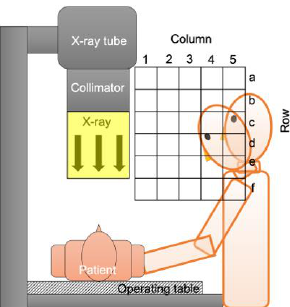
Figure 4. Analysis of physician’s lens position. The physician’s lens is mostly located in Area (d, 4), Area (e, 4) and Area (f, 4) when leaning forward to perform a task, and in Area (c, 5), Area (d, 5) and Area (e, 5) when standing upright to perform a task.